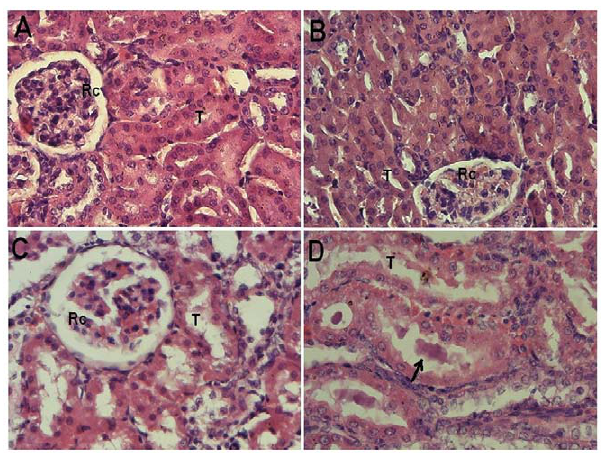
Figure 4. Histomicrograph of mice kidney of major groups. Showing histomicrographs of kidney samples of various groups indicated in parentheses. All the sections have been stained with Hematoxylin and Eosin stain and were snapped at 400 6 . (A) Control [group I] depicts normal renal corpuscles (Rc) and tubules (T). (B) Riboflavin treated [group II] shows features very akin to normal. (C) Cisplatin treated [group III] reveals changes suggestive of dilatation of tubules, and nuclear cytoplasmic dissociation in the tubular epithelium. (D) The combination of cisplatin and riboflavin treated [group IV] shows reasonably intact tubular epithelium and lumen filled with cast ( q